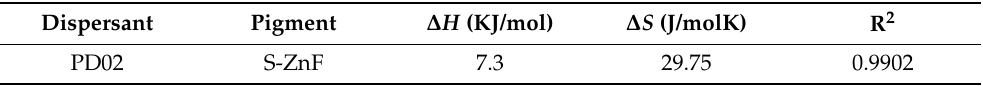
Figure 10. Plot of Ln ( K d ) versus 1/ T for dispersant PD02 adsorbed on the surface of the S-ZnF parti- cles. Table 5. Thermodynamic characteristics for dispersant PD02 adsorbed on the surface of the S-ZnF particles.